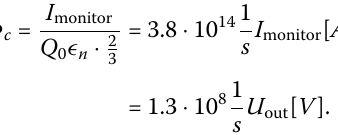
is the corresponding